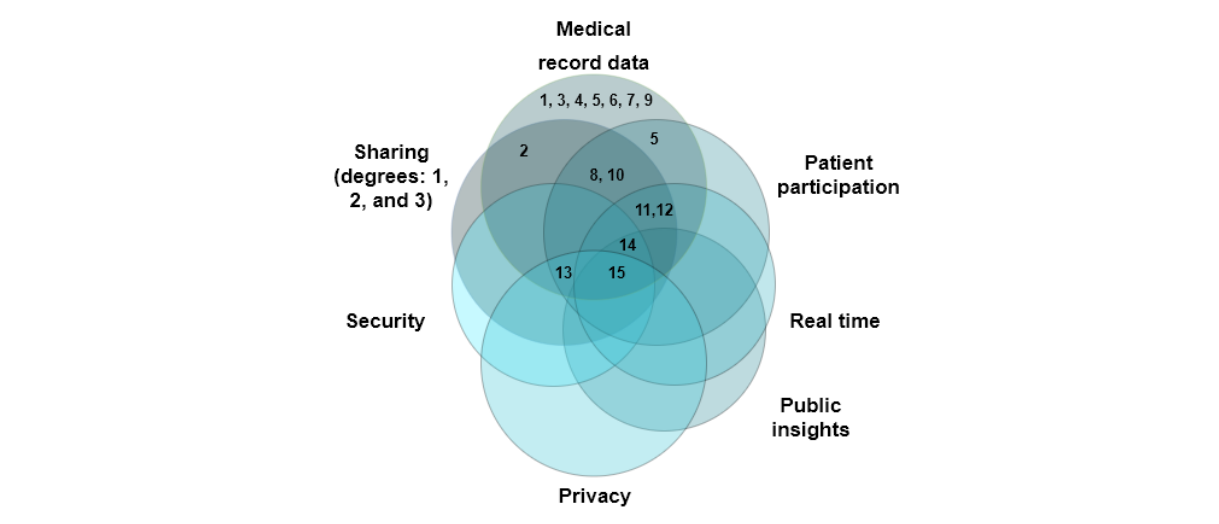
Figure 2. Requirements of a health data management